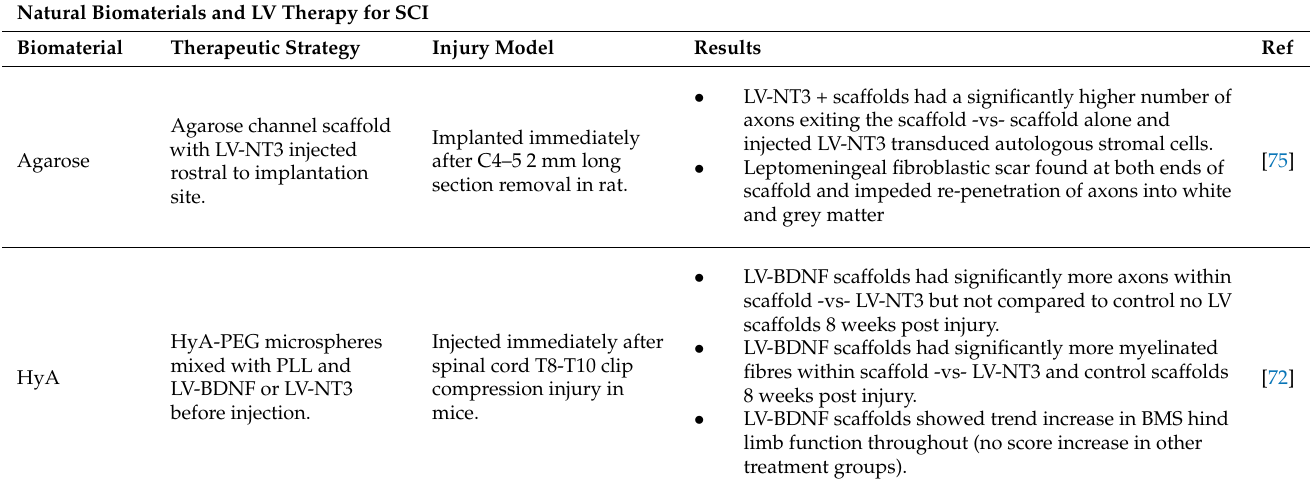
Table 6. Studies combining LVs with natural biomaterials for SCI regeneration. BDNF; Brain derived neurotrophic factor, BMS; Basso mouse scale, HyA; Hyaluronic Acid, NT3; Neurotrophin 3. Natural Biomaterials and LV Therapy for SCI